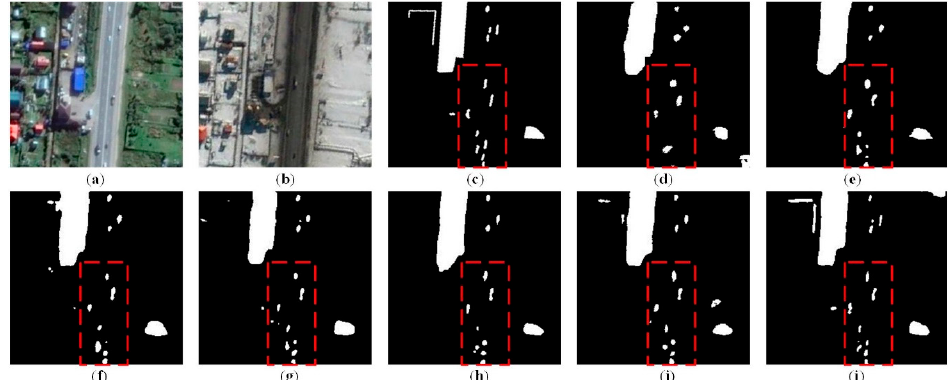
Siam-diff, ( h ) FC-EF-Res, ( i ) FCN-PP, and ( j ) proposed method. The changed parts are marked in white while the unchanged parts are in black. Remote Sens. 2019 , 11 , x